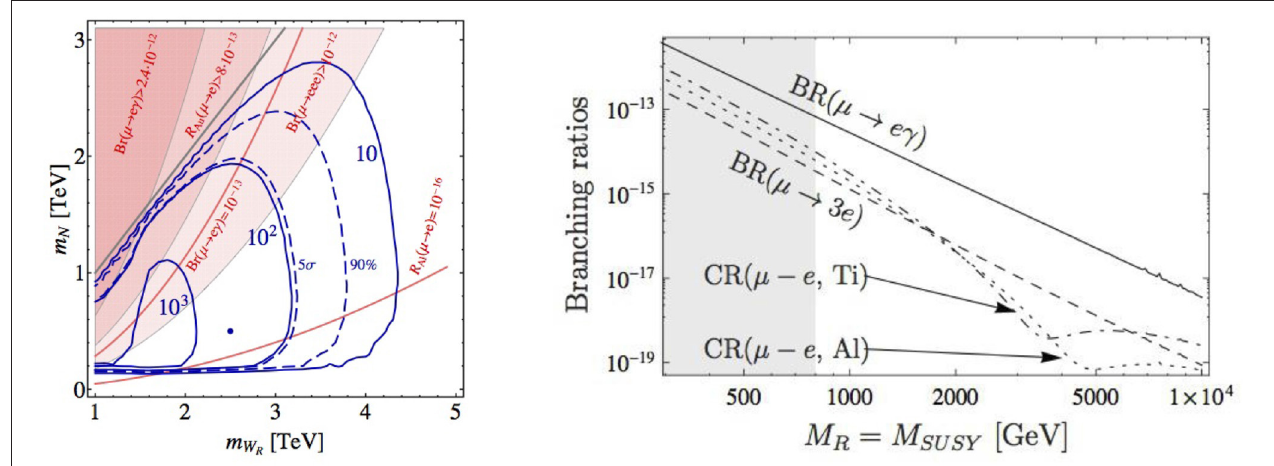
FIGURE 6 | On the (left) , muon cLFV rates in LRSM: rose-shaded areas denote the corresponding experimental regimes (exclusion and future sensitivity); solid lines denote the number of events with a signature e ± µ ∓ with significances at 5 σ (discovery) and 90% C.L. (exclusion). From [ 110], and appearing also in [111] (reproduced with permission from the Authors). On the (right) , predictions for cLFV muon channels obtained in a SISS realisation: BR( µ roughly denotes regimes excluded by direct LHC searches. From Abada et al. [74], reproduced with permission from the